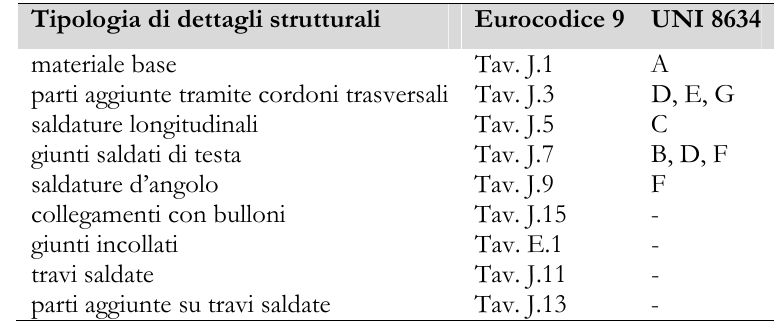
12, 14, 16, 18, 20 ,23, 25, 28, 32, 36 ,40, 45 ,50 ,56, 63 ,71, 80, 90, 100, 112 ,125, 140